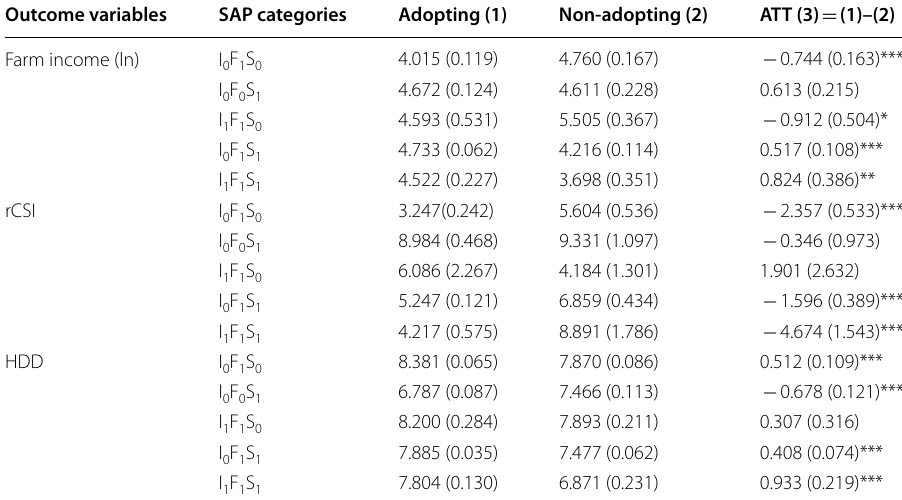
Table 4 Treatment effects of SAP adoption on farm income and food